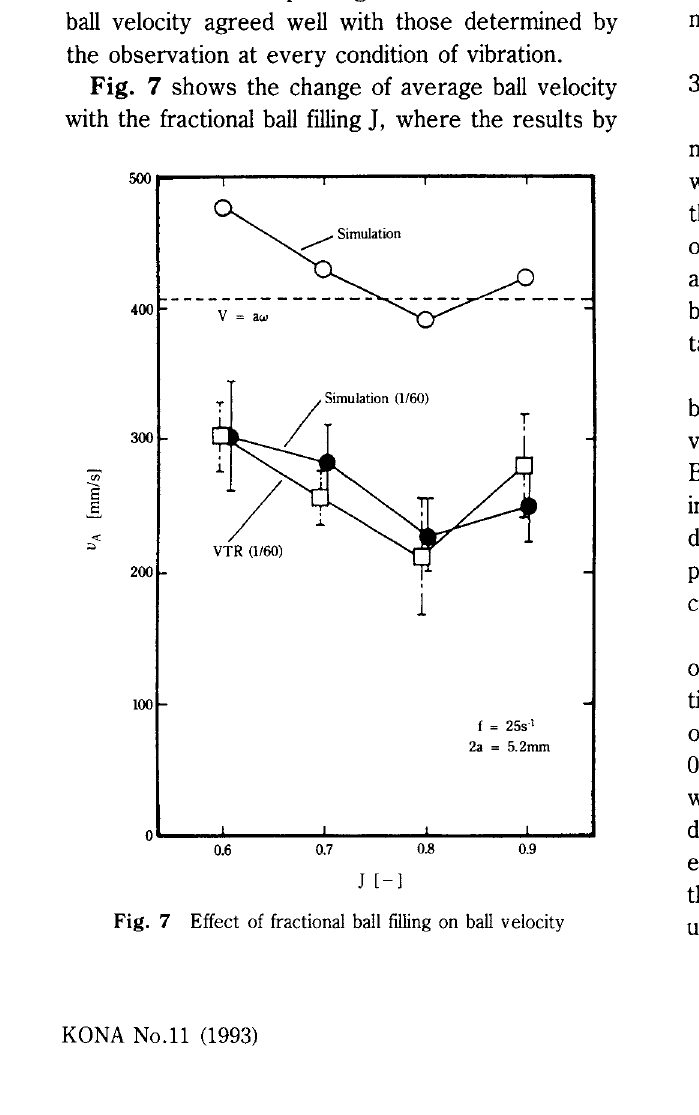
Fig. 7 Effect of fractional ball filling on ball velocity